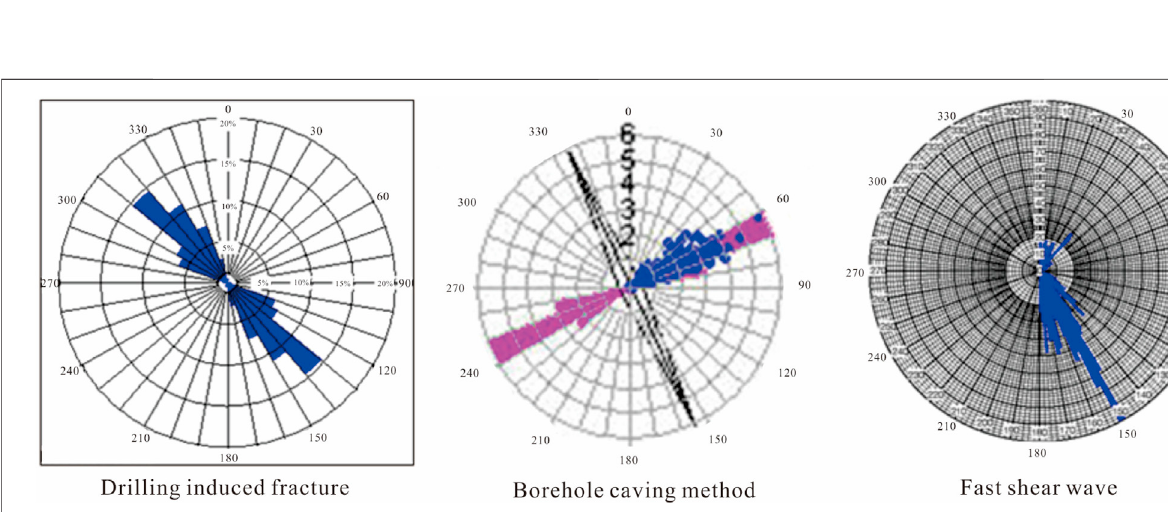
Frontiers in Earth Science |